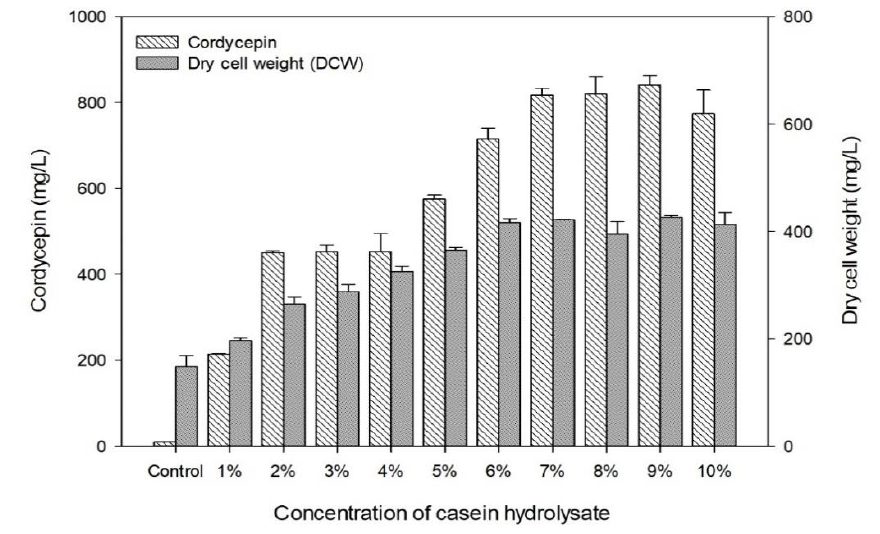
Figure 4. Effects of CH concentrations on dry cell weight and cordycepin production by C. militaris Figure 4. E ff ects of CH concentrations on dry cell weight and cordycepin production by C.